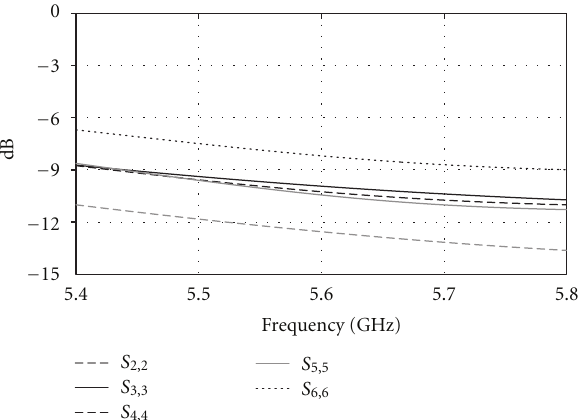
Figure 5: Some S ii parameters of the array of monopoles.